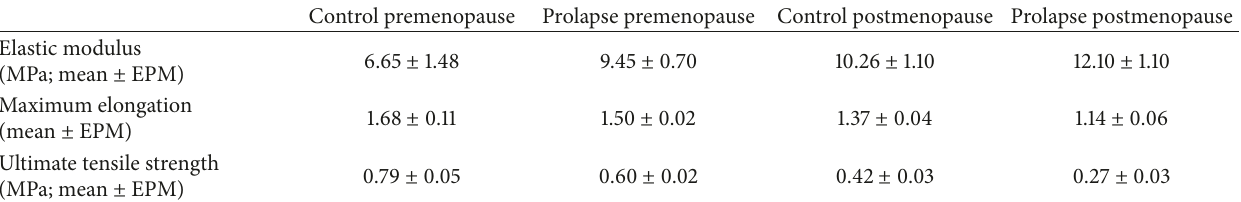
Table 1: Elastic modulus, maximum elongation, and ultimate tensile strength in women with and without prolapse (adapted from Lei et